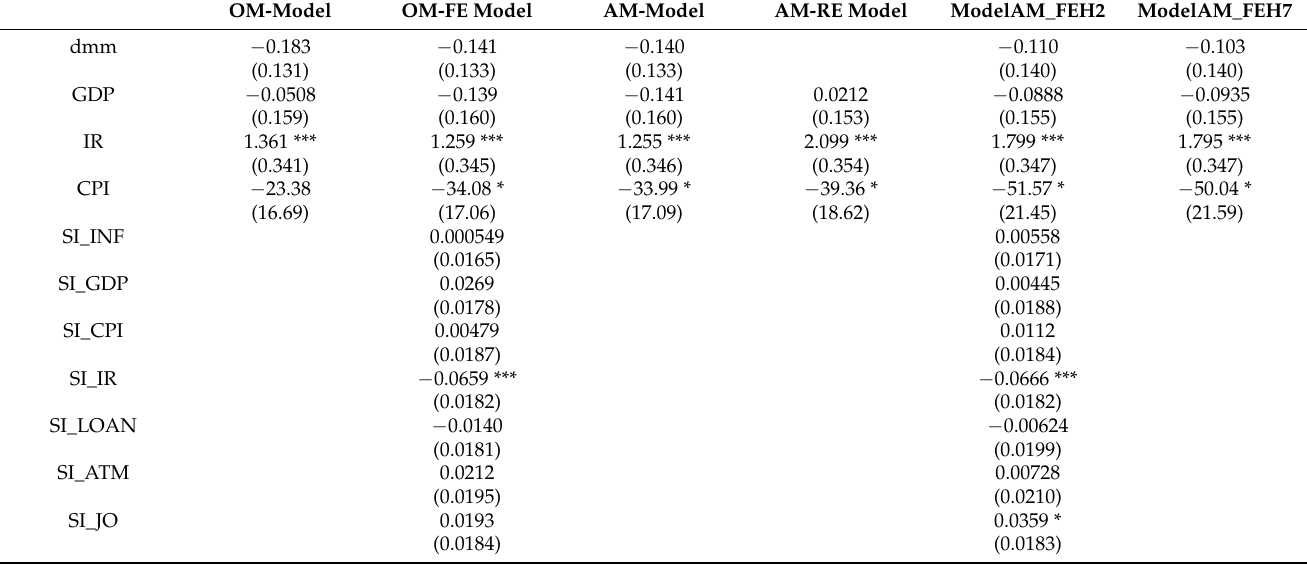
Table A18. Panel Regression OM- And AM-Model 2 with Random-Effects